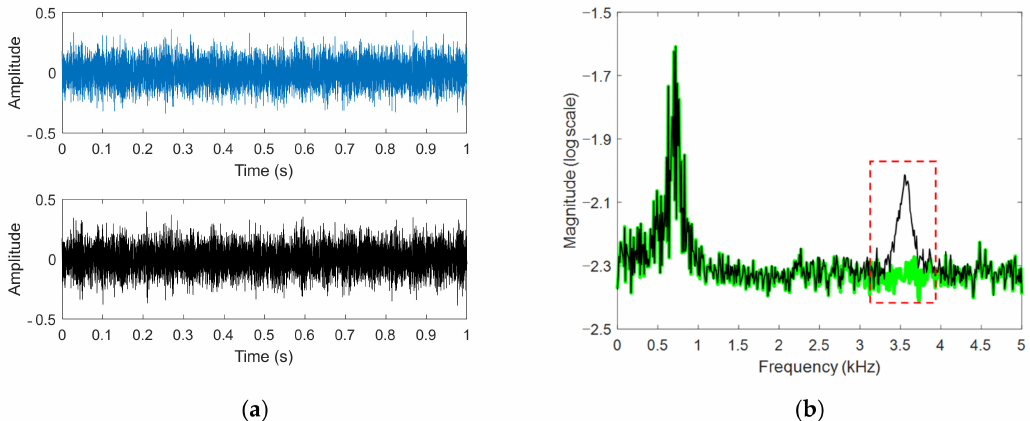
Figure 2. Signal models for envelope analysis: ( a ) normal signal model (top) and faulty signal model (bottom); ( b ) spectrum of normal signal model (green) and spectrum of faulty signal model (black).